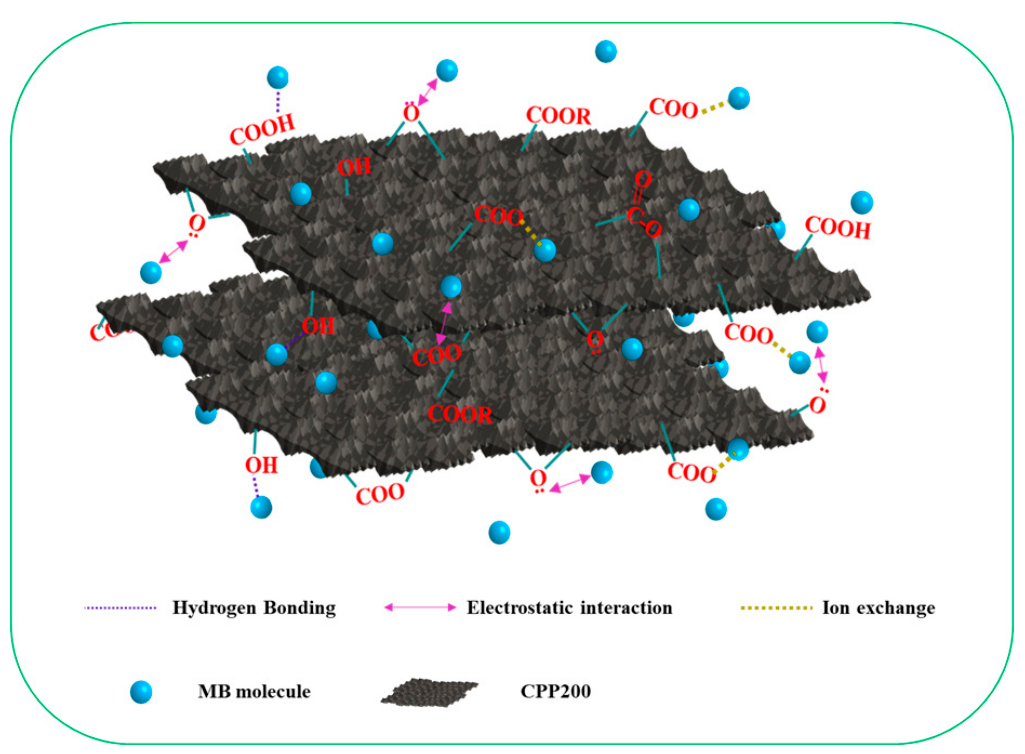
Figure 11. A proposed mechanism for MB adsorption by CPP200.